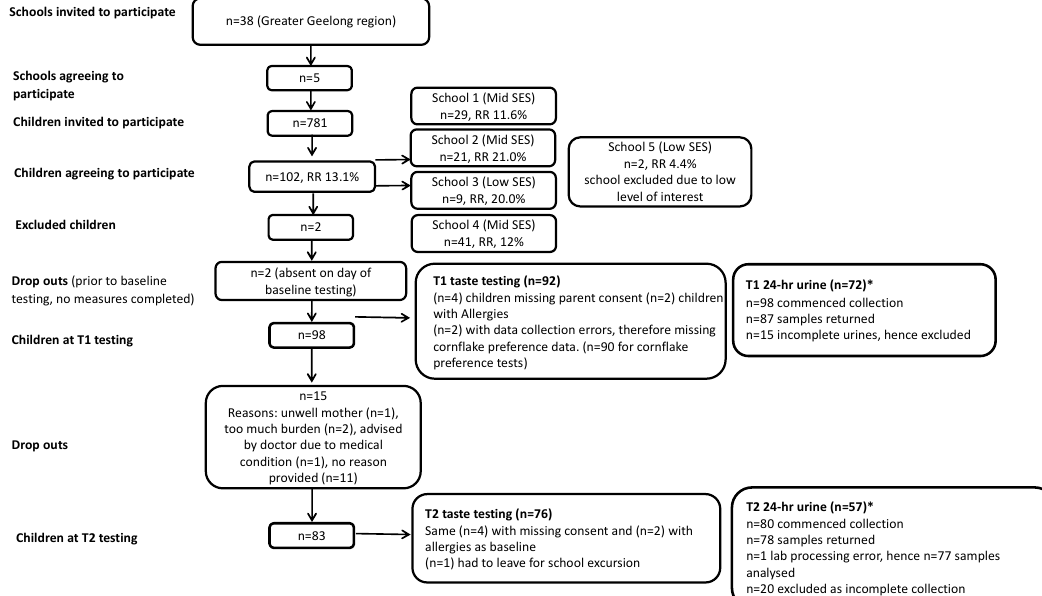
Figure 1. Flowchart of participant recruitment and retention within the Digital Education to Limit Salt in the Home program. * Further information on urine collection numbers have been previously reported [37]. Table 2. Characteristics of participating children at T1 data collection ( n = 92).